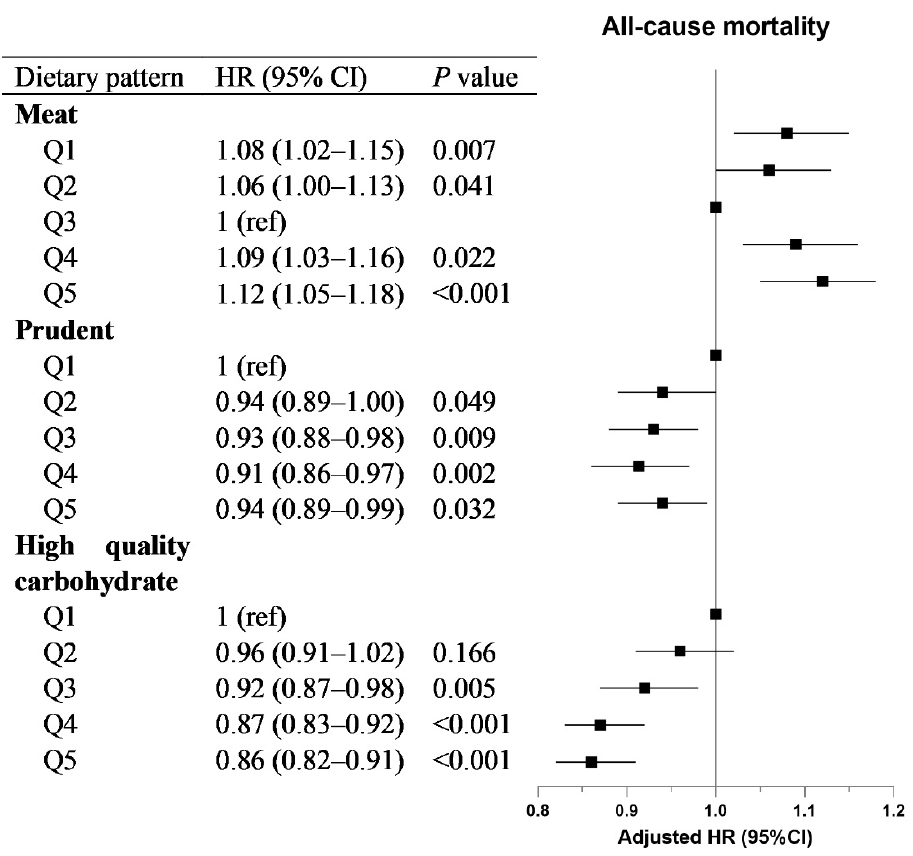
Figure 2. Association of dietary patterns with all-cause mortality. For the meat diet pattern, the quintile with the lowest hazard ratio (Q3) was set as a reference. The model was adjusted for age, sex, ethnicity, Townsend deprivation index (quintiles), education level (university/college degree or others), household income (less than £18,000, £18,000 to £30,999, £31,000 to £51,999, £52,000 to £100,000, greater than £100,000, or do not know/prefer not to answer), self-reported smoking status (never, former or current smoker), sedentary behavior, body mass index, baseline diabetes, baseline hypertension, serum alanine aminotransferase, triglycerides and cholesterol.